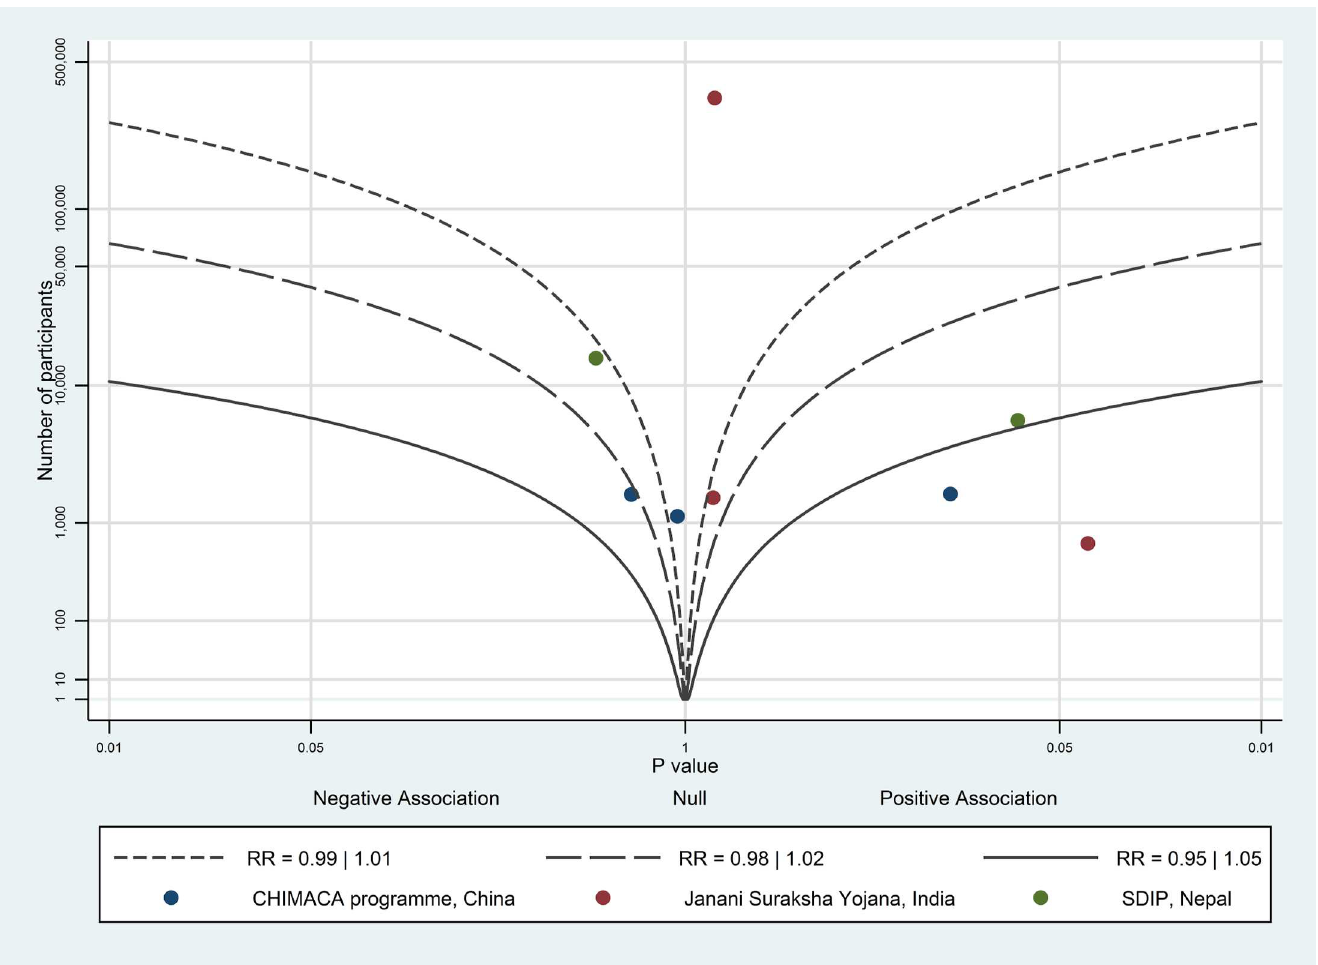
Fig 7. Albatross plot for effect of short-term cash payments on birth with a skilled birth attendant or birth in healthcare facilities in case of complications. SDIP—Safe DeliveryIncentive Programme.